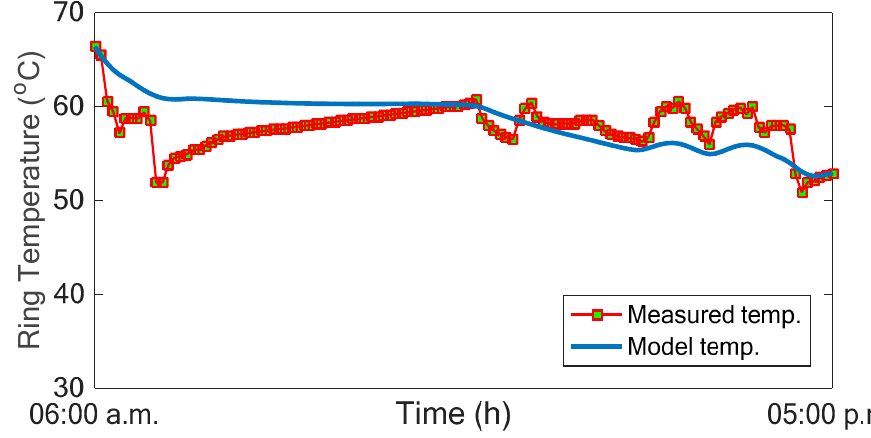
Figure 7. Ring temperature (V C 0 ) profile: measured data against model results from 6 a.m. to 5 p.m.